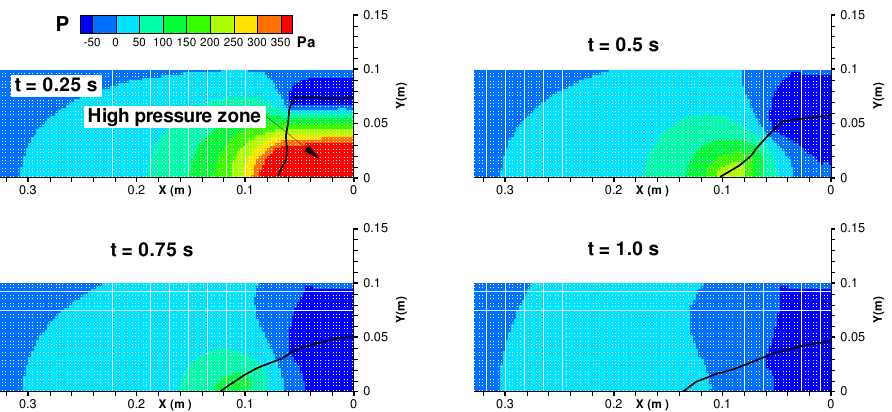
Figure 15. Numerical results show the relative pore water pressure field evolution during the collapse process of an initially loose packing submerged granular